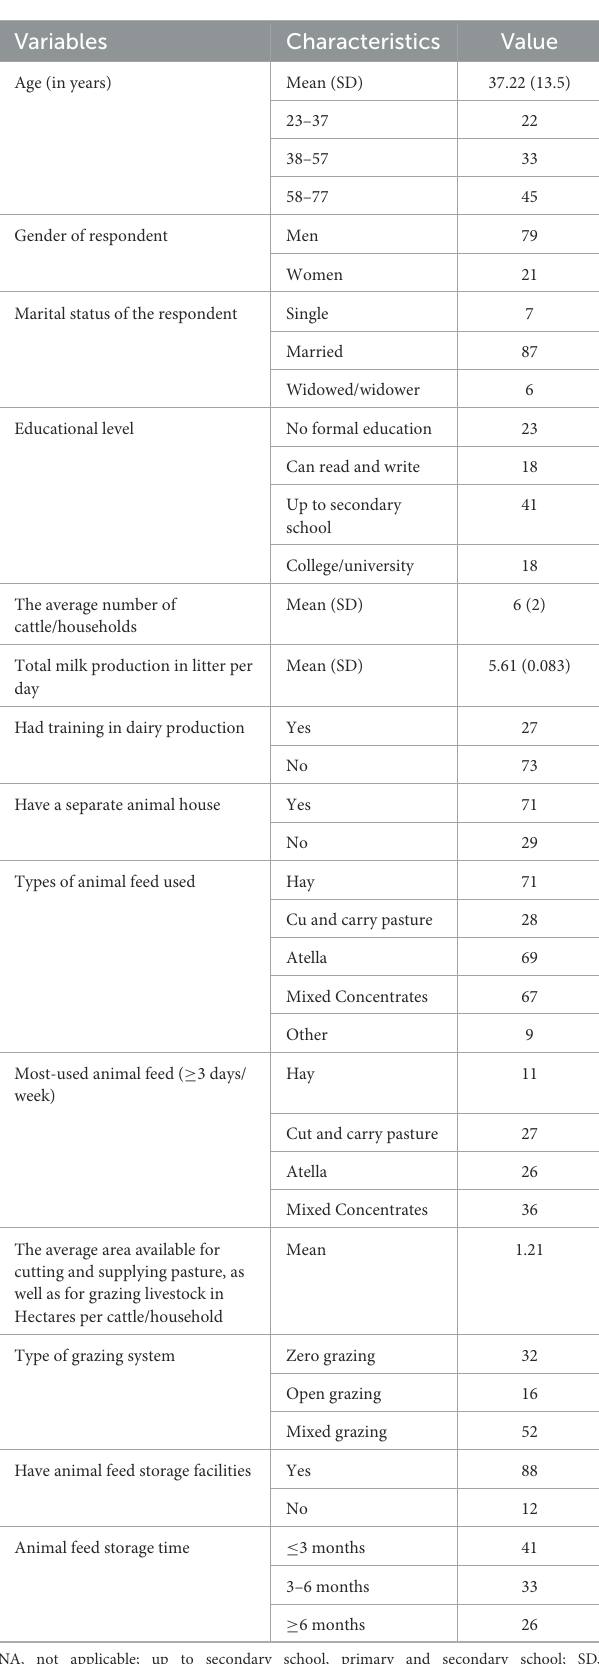
TABLE 1 Socio-demographic characteristics of dairy farms in the locality of SGZ, Ethiopia ( N = 100).